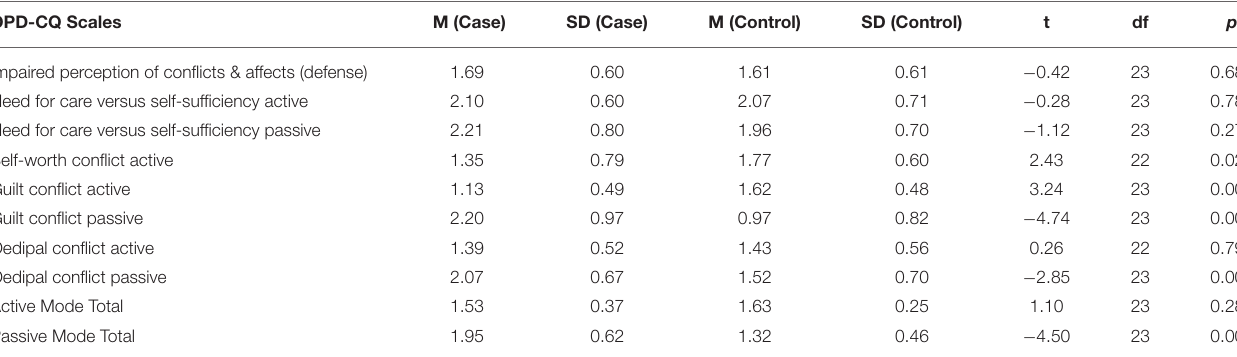
TABLE 5 | Comparison of OPD-CQ scores (paired-samples t- test). OPD-CQ Scales